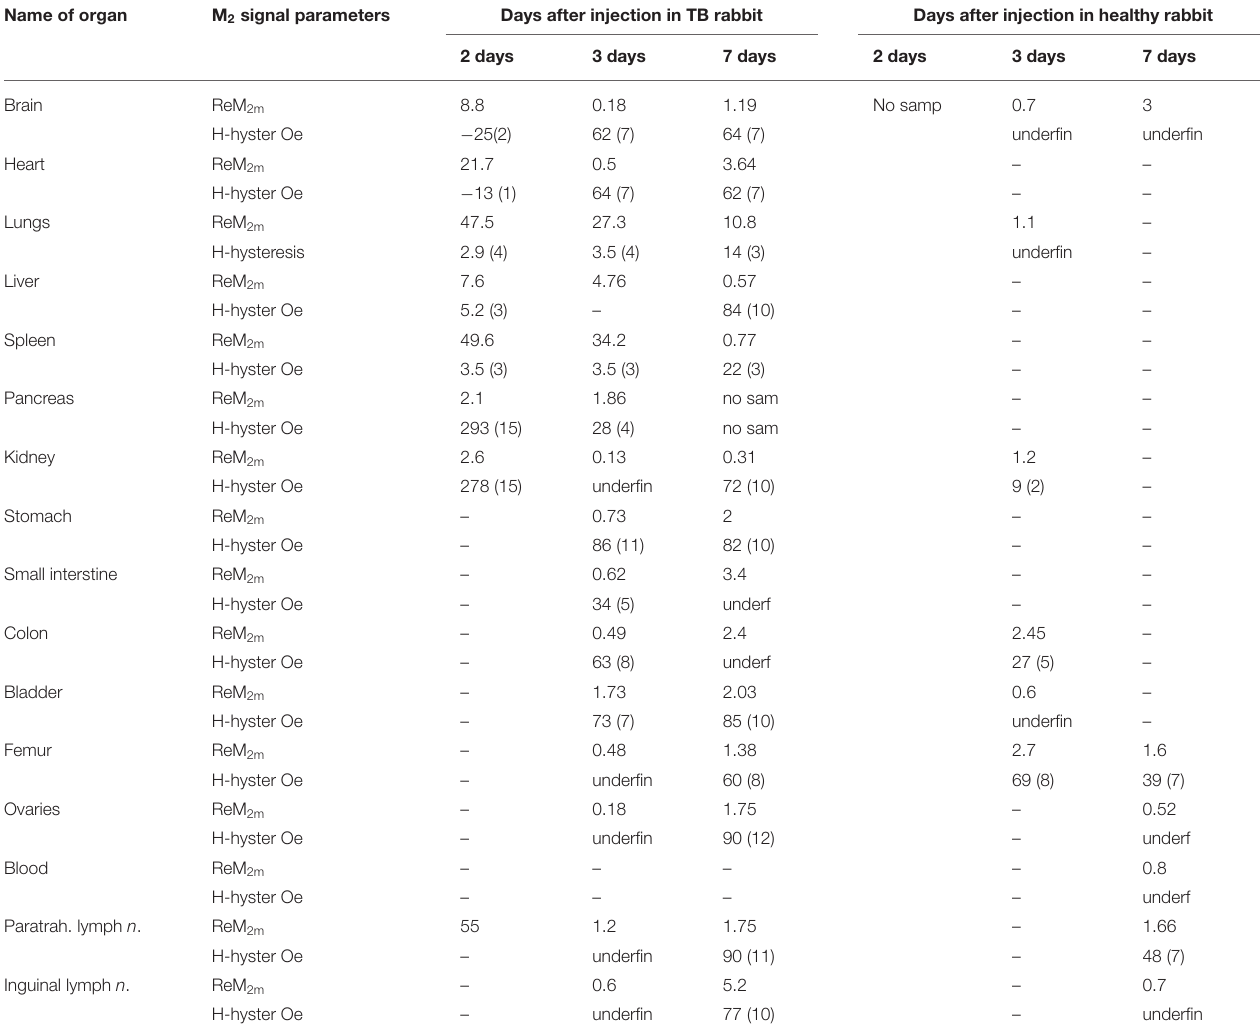
TABLE 2 | Biodistribution of SPION-labeled MSCs in animals with renal TB at different time points. Name of